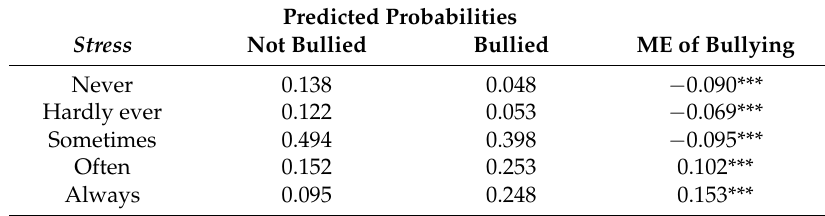
Table 4. Estimated marginal effect of bullying on work-related